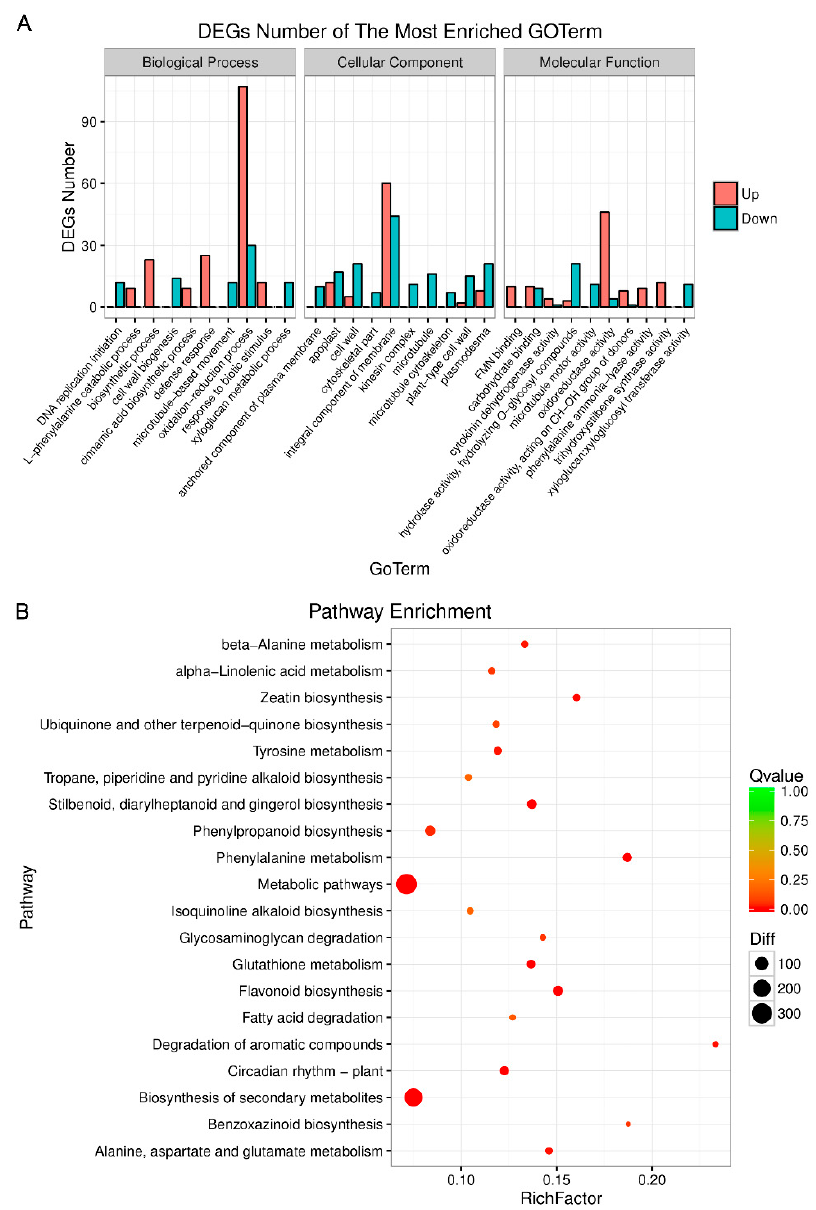
Figure 2. The enrichment of Gene Ontology (GO)- and Kyoto Encyclopedia of Genes and Genomes (KEGG)-based distribution of DEGs incubated with D. seriata 98.1. ( A ) The most significantly enriched biological process, cellular component and molecular function of GO enrichment ( p -value < 0.05). ( B ) The DEGs enriched in different biological pathways were analyzed with the KEGG database. The RichFactor represents the ratio of enriched DEGs to all genes in the corresponding pathway. Diff rep- resents the number of DEGs enriched in the corresponding pathway. A lower Q-value represents a higher significant degree of enrichment.